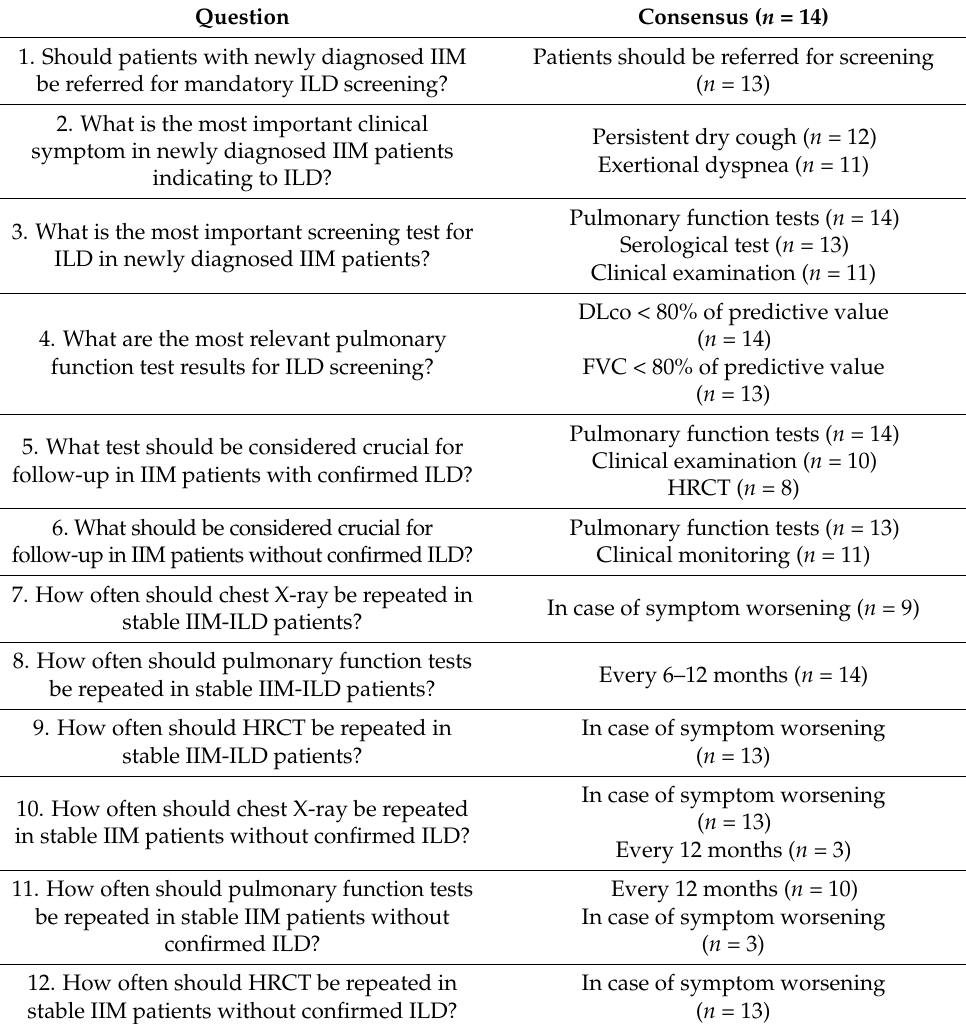
Table 4. Consensus results of the IIM questionnaire for screening and monitoring ILD. Question Consensus ( n =